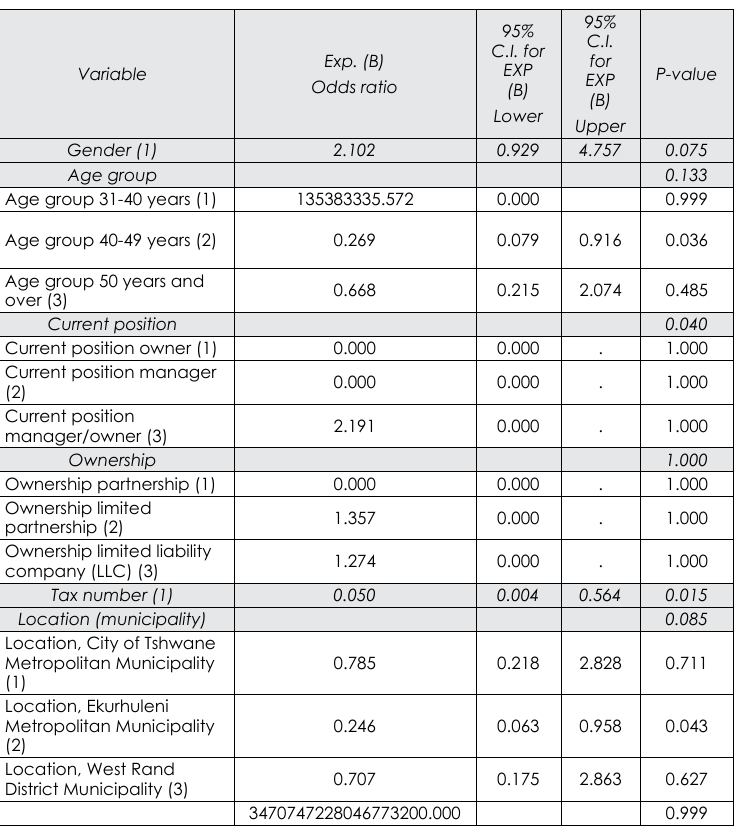
Predictors of accessing full